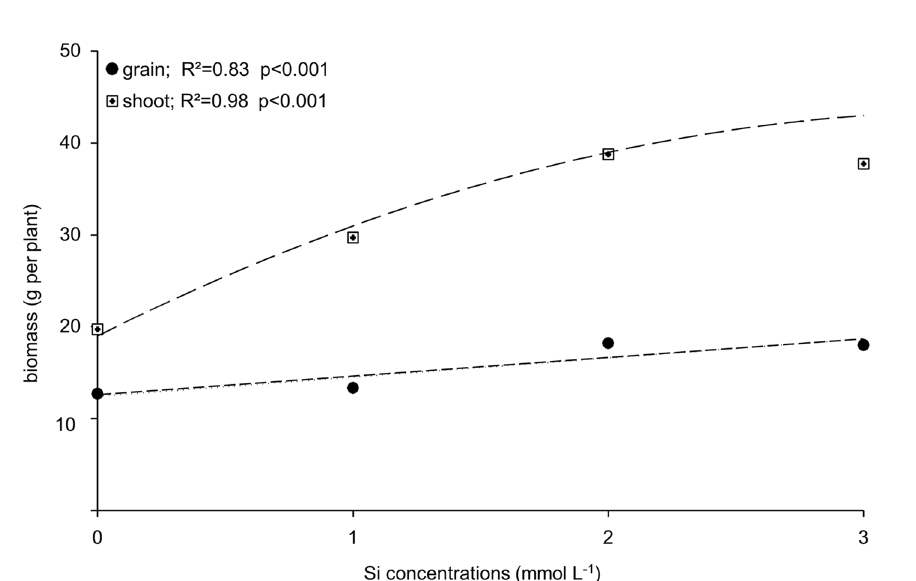
Figure 5. Shoot and grain biomass of quinoa for the studied Si